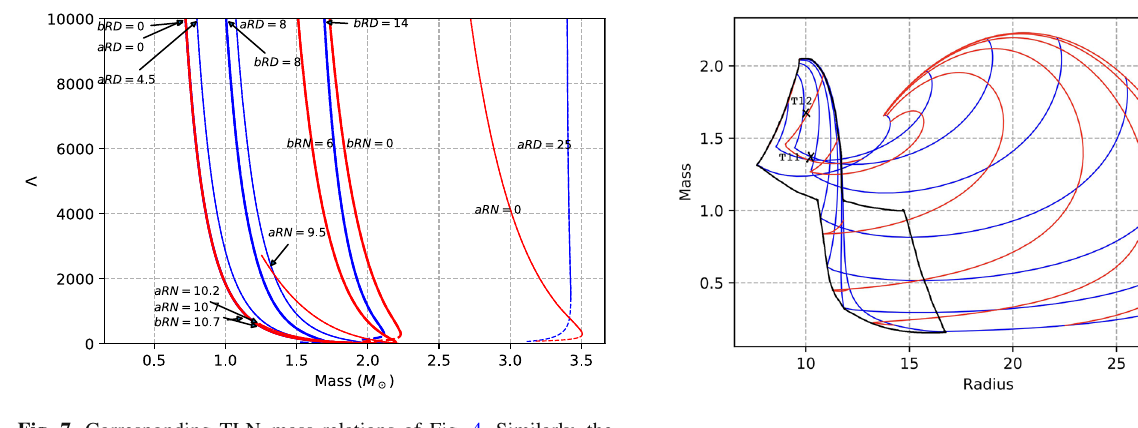
Fig. 7 Corresponding TLN–mass relations of Fig. 4. Similarly, the unstable configurations are indicated by the parts of dashed lines